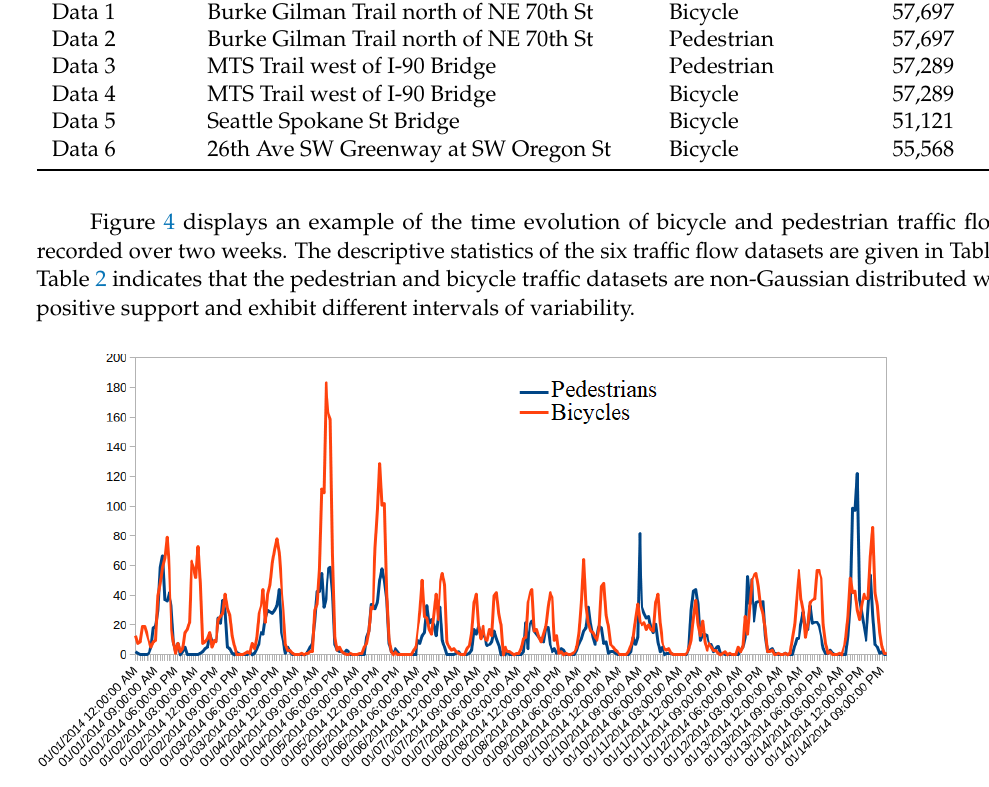
Figure 4. A week of traffic data from Data 1 and Data 2. Table 2. Statistics summary of the pedestrian and bicycle traffic flow